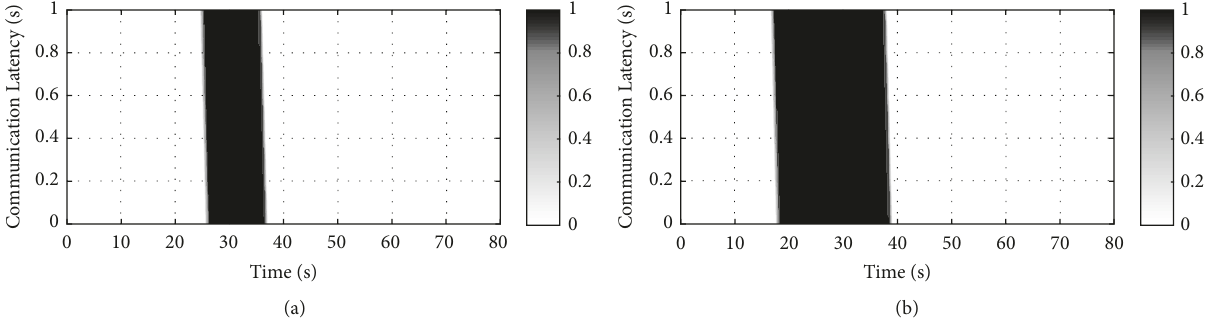
Figure 6: Crossing risk probability for different communication latencies. (a) No-control scenario. (b) Control scenario.